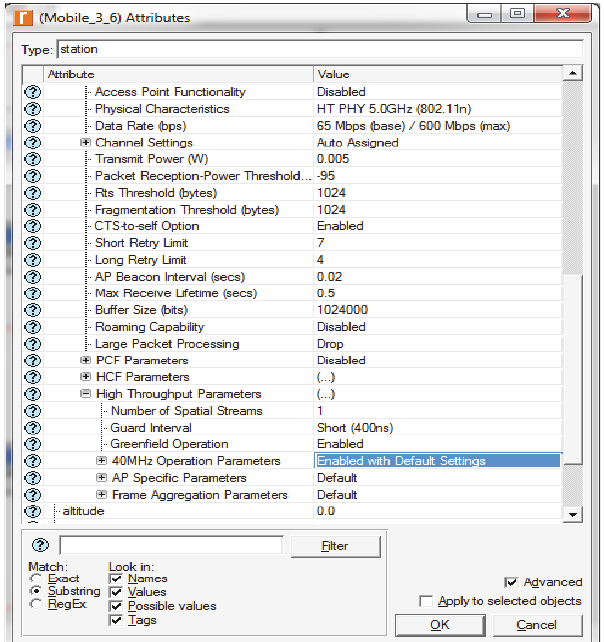
Figure 42: Values of various parameters.